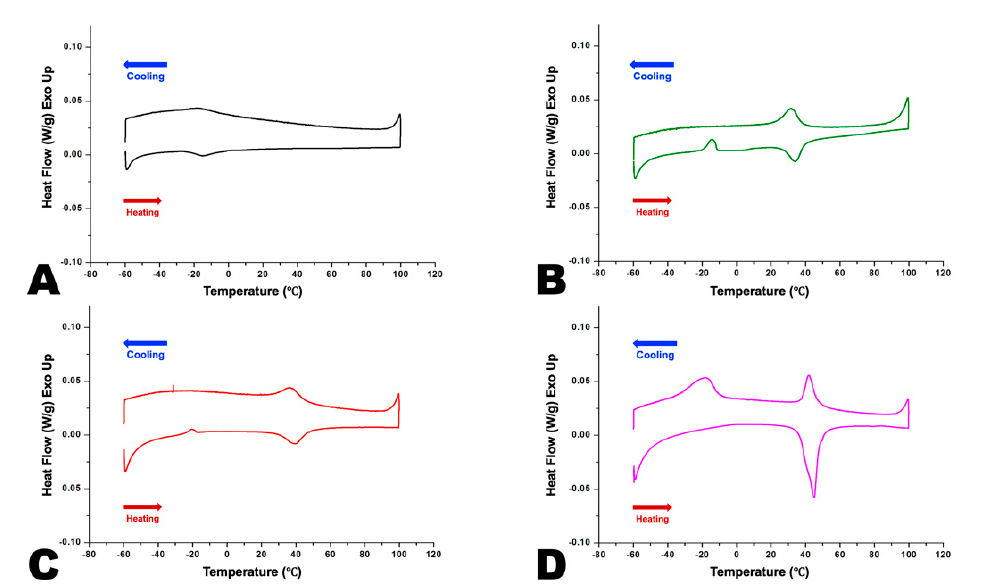
Figure 2. Differential scanning calorimetry (DSC) diagram from: ( A ) OneShape, ( B ) OneCurve, ( C ) WaveOne Gold and ( D ) Hyflex EDM NiTi instruments.